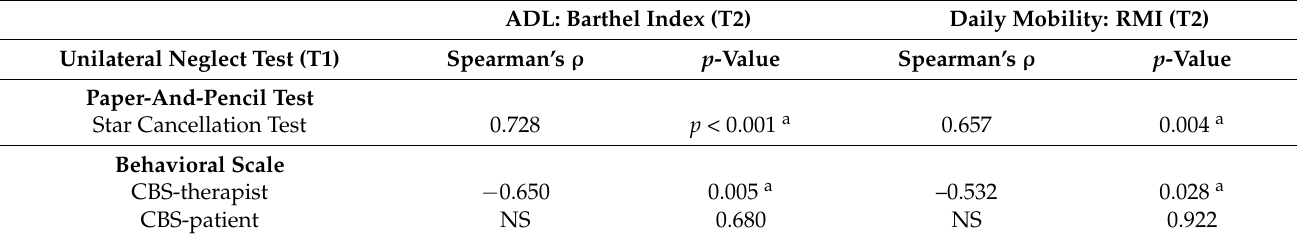
Table 2. Correlations between the presence of unilateral negligence and the functional outcomes ( n = 17).